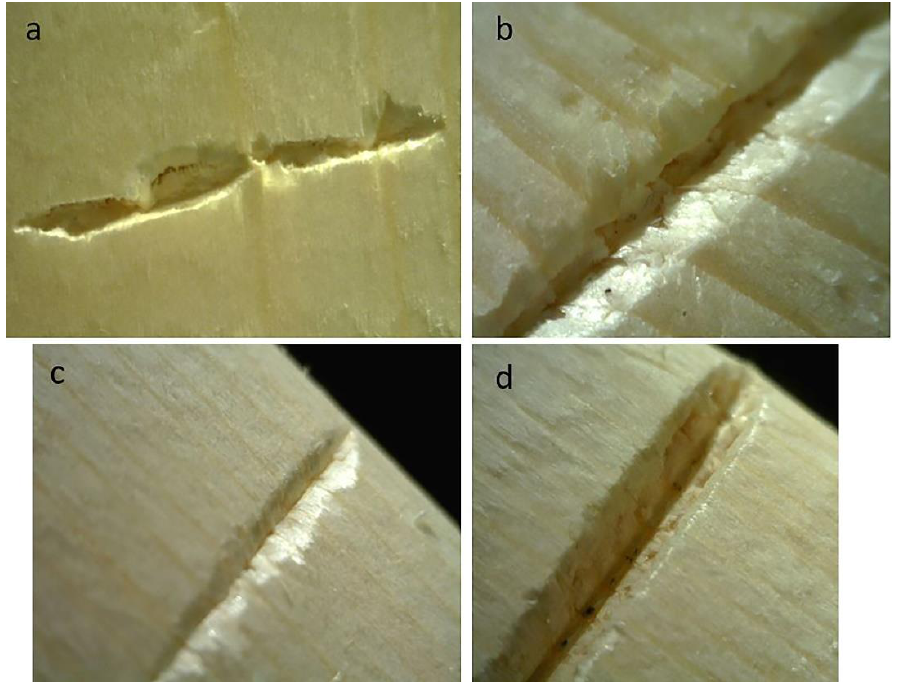
Figure 12. Photographs of incomplete (not fully severed) marks on wood; ( a ) flint chipped stone, ( b ) ground stone, ( c ) copper, and ( d ) bronze.